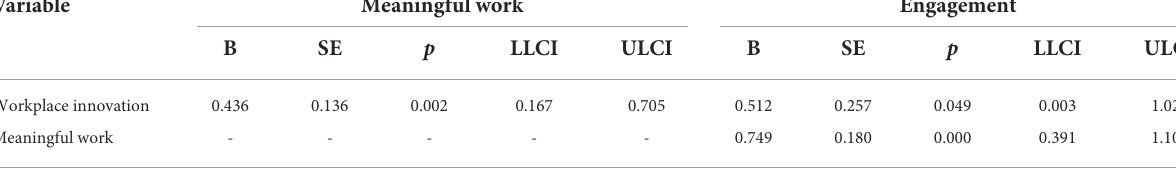
TABLE 2A Mediation results for engagement.